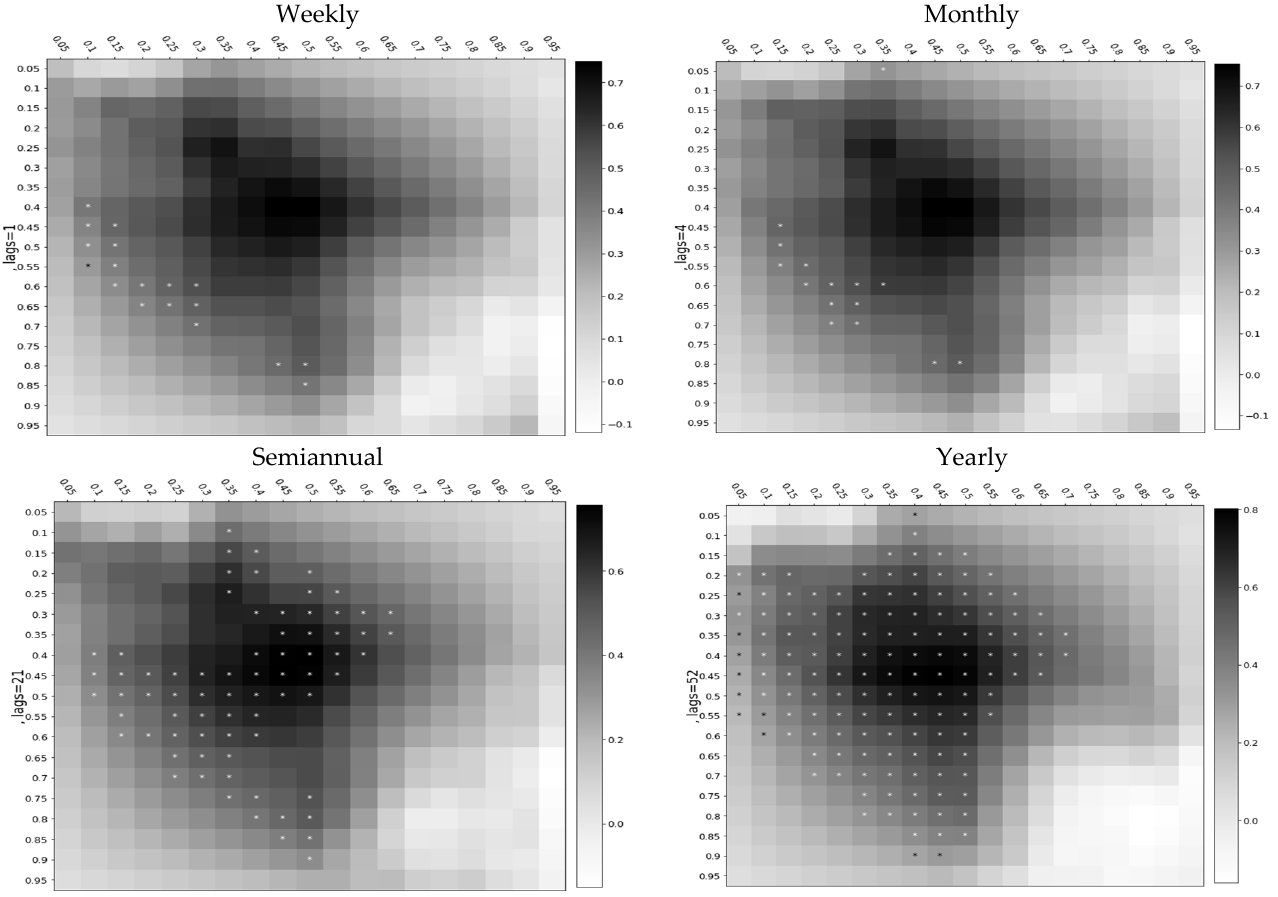
Figure 3. Cross-quantile dependence from oil price to foreign liabilities. Note: * indicates significance at 10% level.